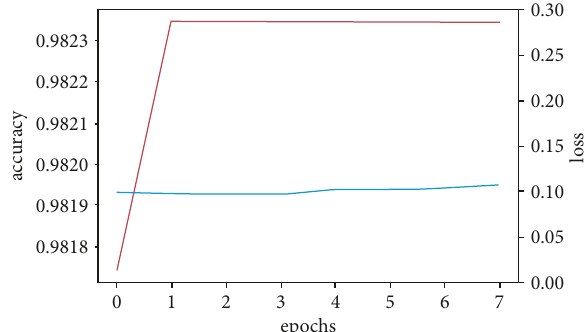
Figure 13: CNN model three accuracy fluctuation.